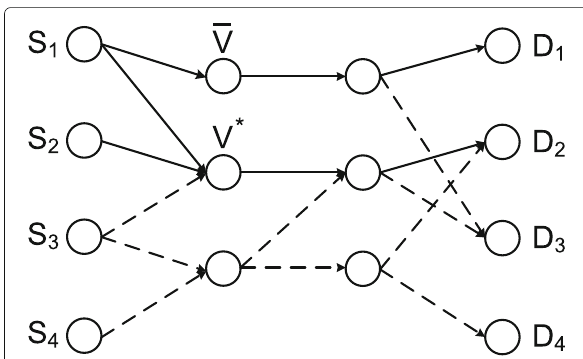
Fig. 18 A path exists from source S 1 to destination D 2 ; all solid edges have capacity n (for linear deterministic model) or h (for the Gaussian model) and the rest have capacity